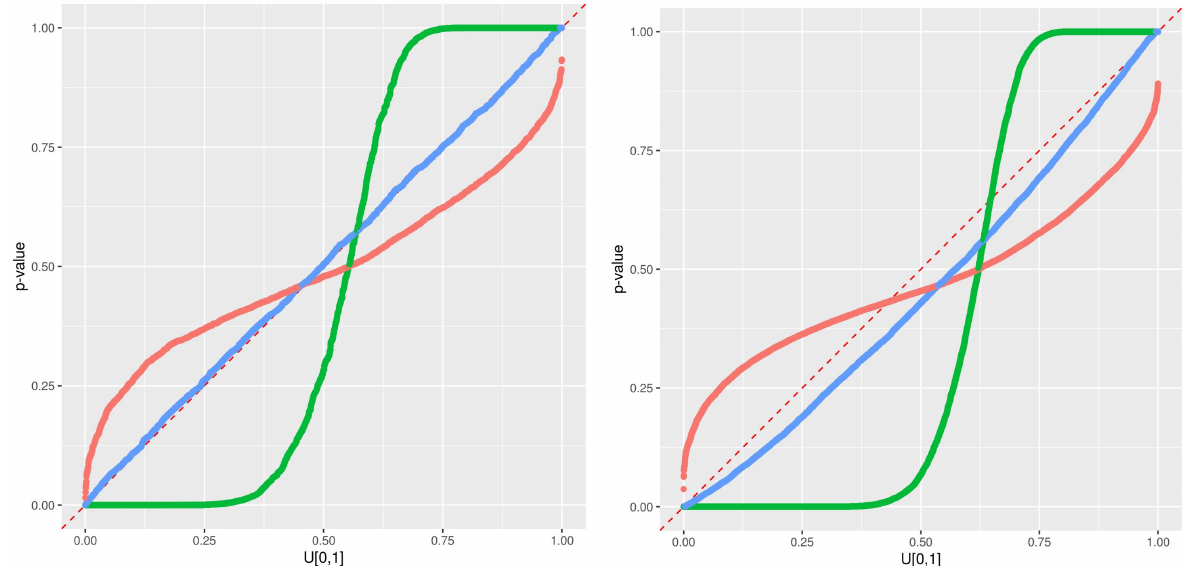
Figure 9. Results at Station 11. Predictive qq-plot for the training/testing period 2017–2018 ( left ). Predictive qq-plot for the validation period 2015–2016 ( right ). The different methods are colored in red for Eaamm 2010, green for Wager 2014 and blue for Lu